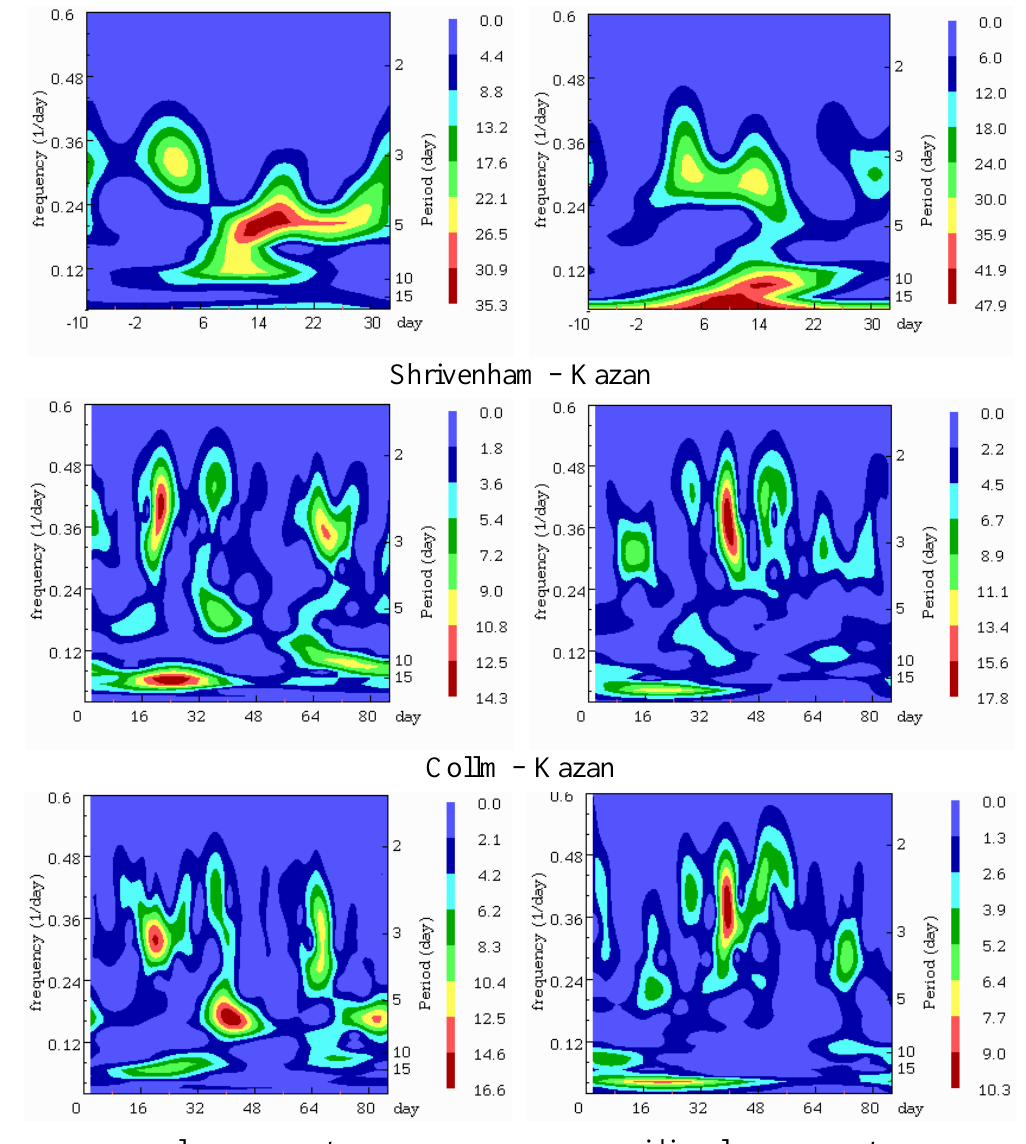
Fig. 11b. Spectrograms for the mean wind variations over Obninsk (top panel). Cross-S-transform results for the mean wind data of Shrivenham and Kazan (middle panel) and for the mean wind data of Collm and Kazan (bottom panel).